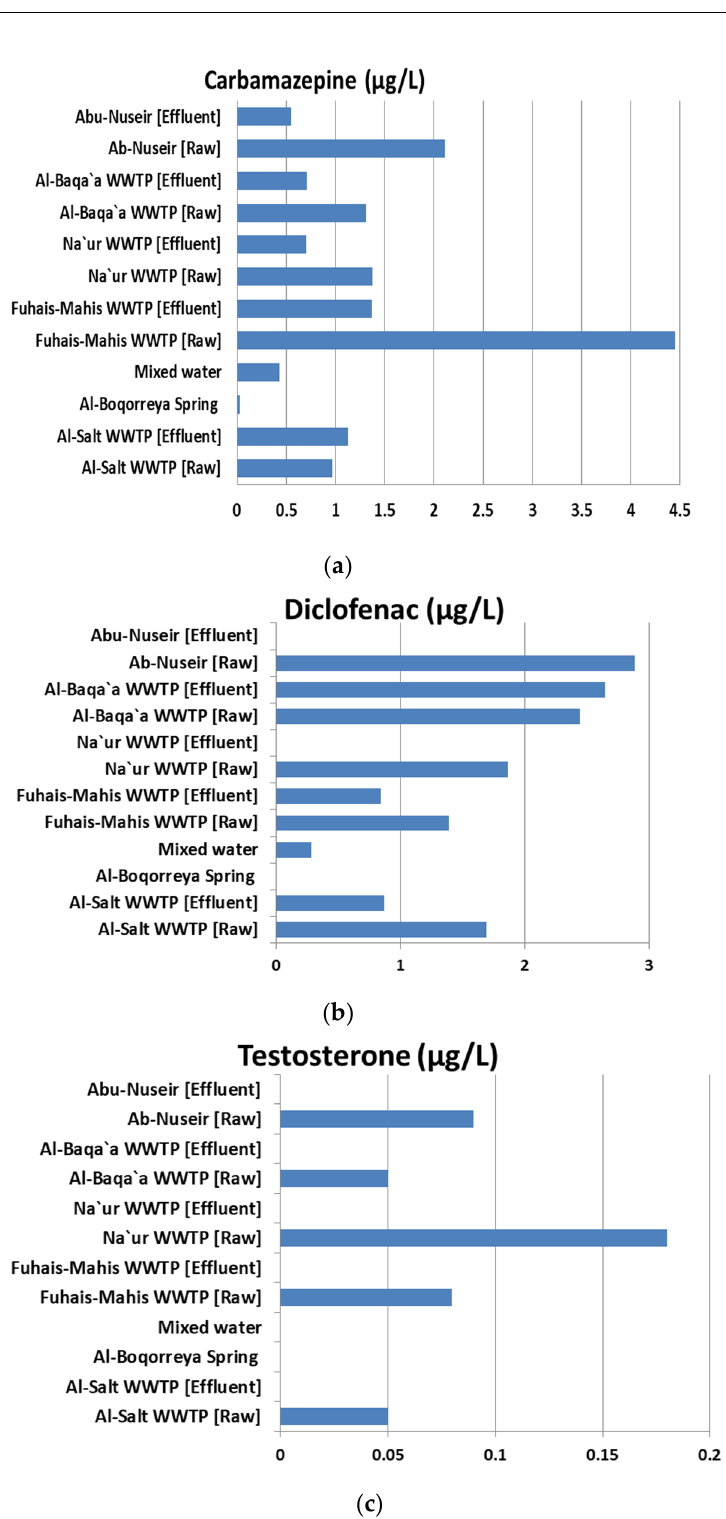
Figure 2. Concentration of: ( a ) Carbamazepine concentrations, ( b ) Diclofenac concentrations, and ( c ) testosterone hormone concentrations of the investigated water samples.